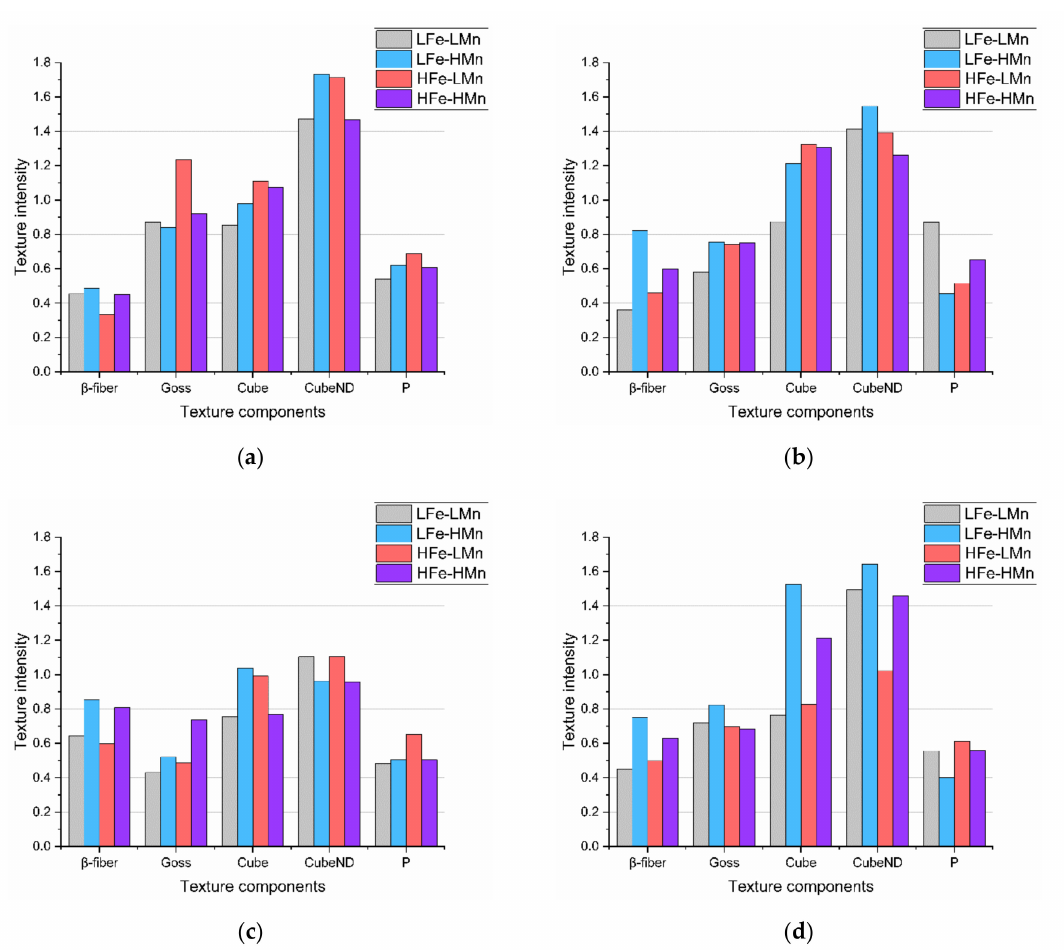
Figure A29. Rolling and recrystallization texture components for the samples states not included in Figure 9. ( a ) NR-C cast, 500 ◦ C homogenized and 63% CRD. ( b ) S-C cast, 500 ◦ C homogenized and 63% CRD. ( c ) S-C cast, 550 ◦ C homogenized and 35% CRD. ( d ) S-C cast, 550 ◦ C homogenized and 63%